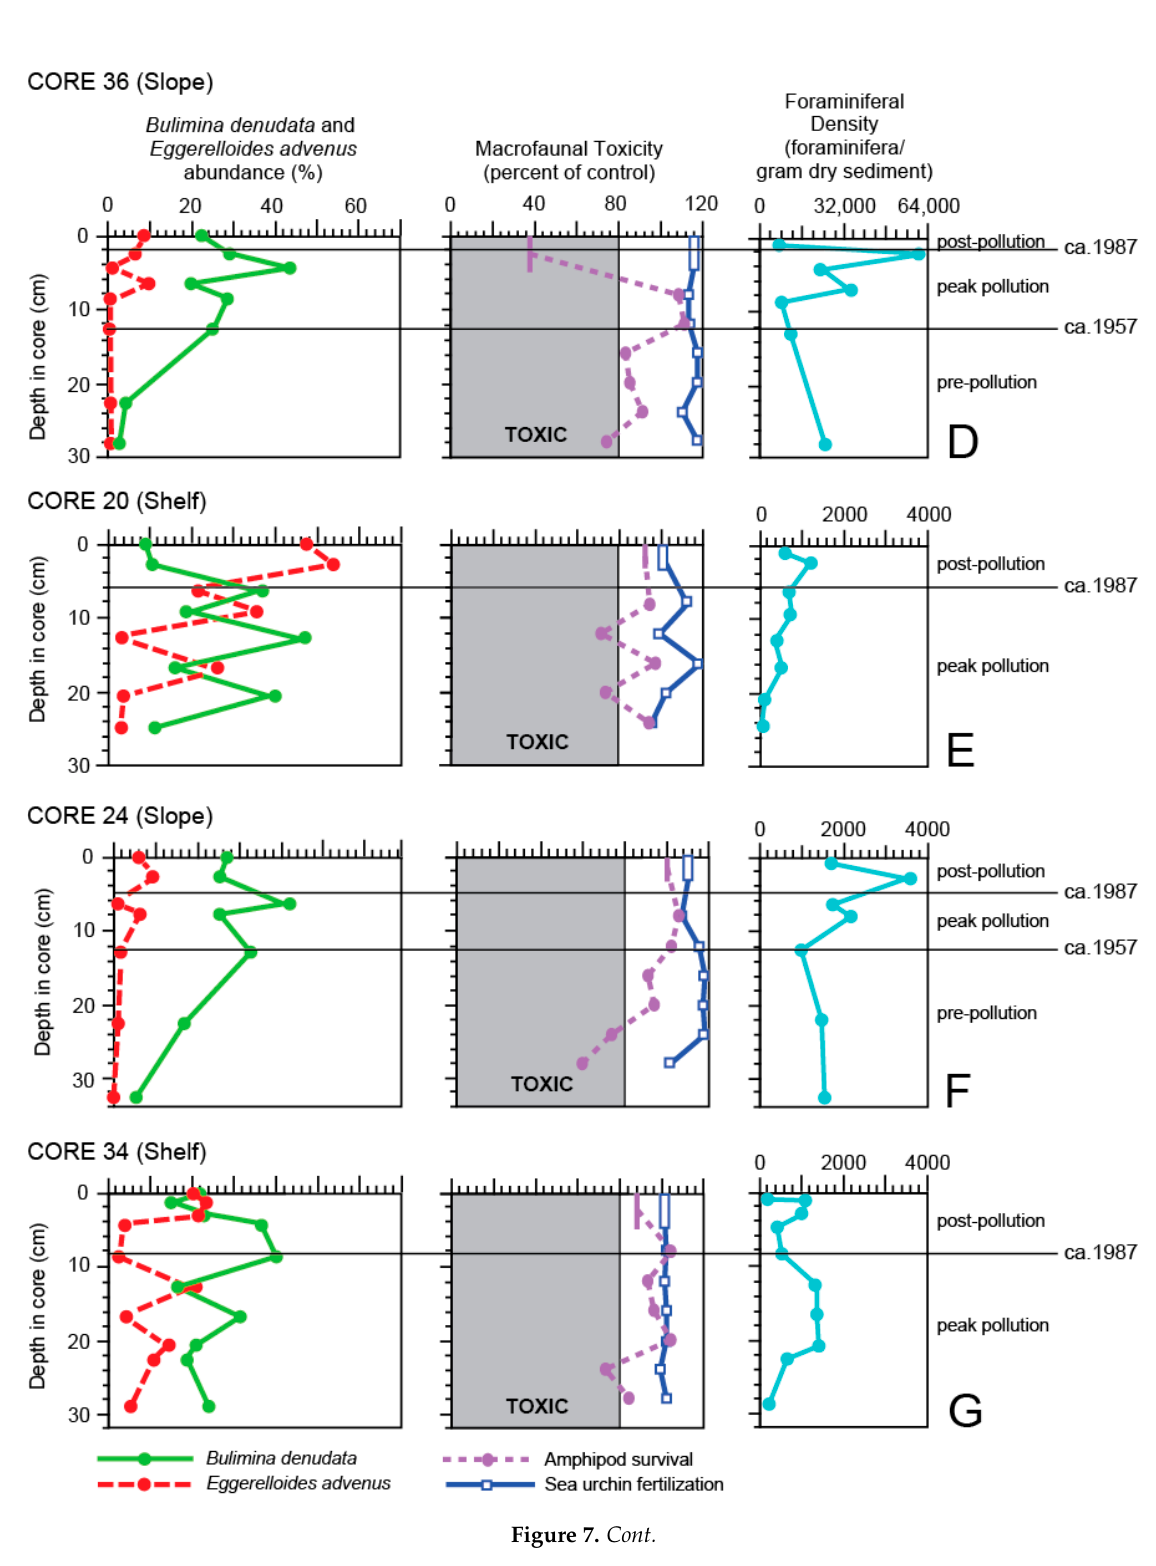
Figure 7. Relative abundances (percent) of foraminifers Bulimina denudata and Eggerelloides advenus , macrofaunal toxicity Figure 7. (amphipod survival and sea urchin fertilization), and Foraminiferal Density (number of foraminifera/gram dry sediment) with depth in core. Toxicity data as percent of control and midpoint of data range plotted. Five cores have composite